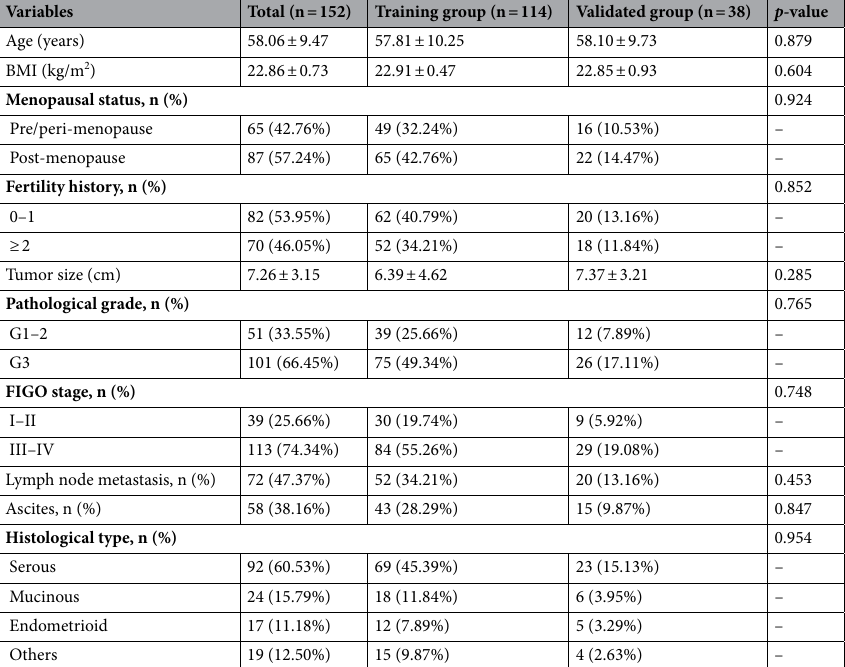
Table 1. Baseline clinicopathological characteristics of the 152 epithelial ovarian cancer (EOC) patients involved grouped by training set and validation set. BMI Body Mass Index, FIGO the International Federation of Gynecology and